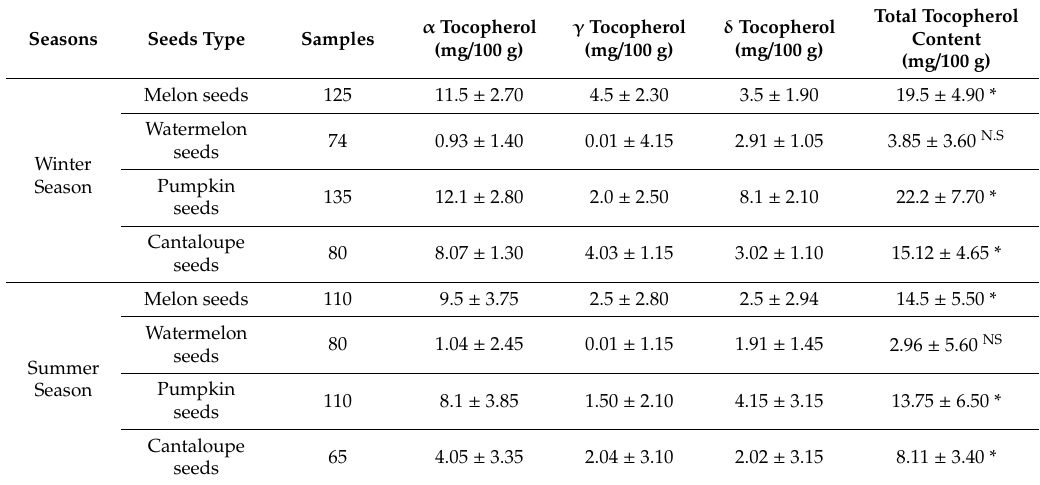
Table 4. Detection of vitamin E content in edible seeds from Punjab,